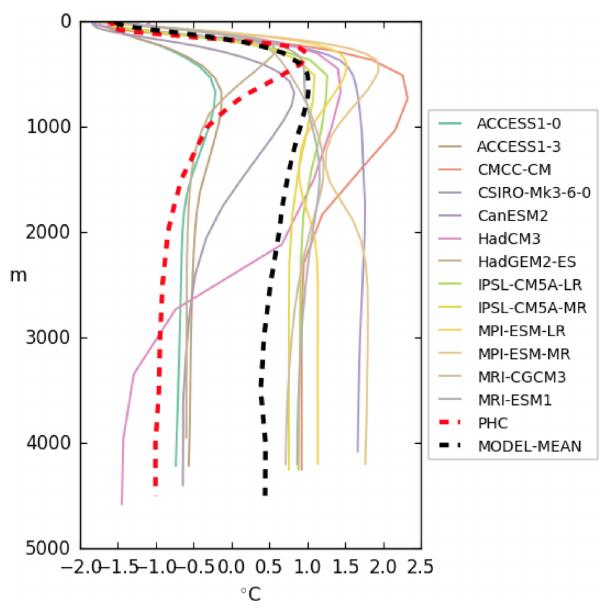
Figure 29. Mean (1970–2005) vertical potential temperature dis- tribution in the Eurasian Basin for CMIP5 coupled ocean models, PHC3 climatology (dotted red line), and multi-model mean (dotted black line). Similar to Fig. 7 of Ilıcak et al. (2016) and produced with recipe_arctic_ocean.yml ; see details in Sect.